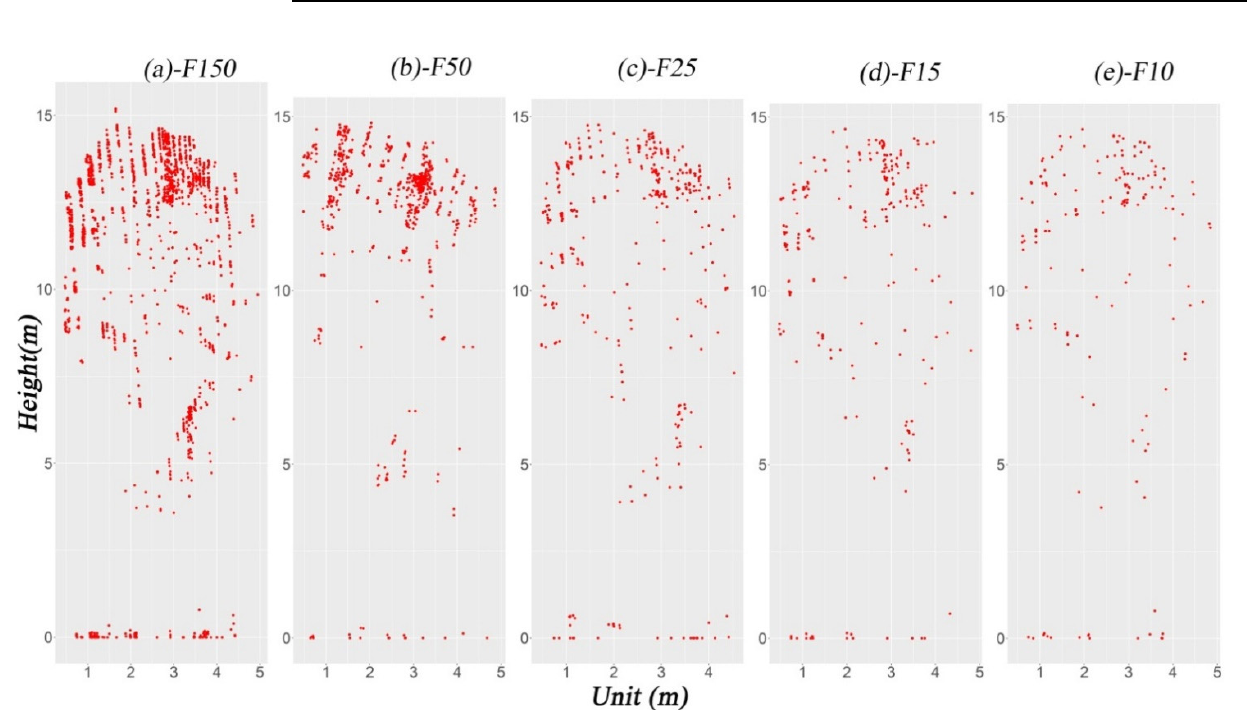
Figure 2. Two-dimensional point cloud images of single trees with different point cloud densities.